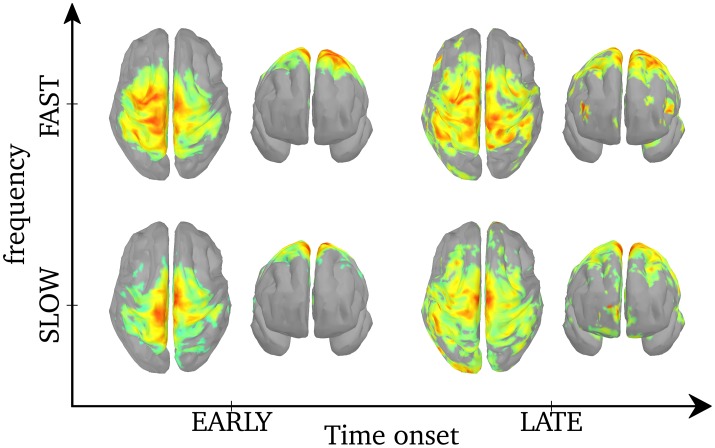
Activation maps associated with each of the 4 categories of SEs. The maps are normalized to a common scale (maximum power in red) and displayed using Otsu's threshold (Otsu, 1979). Based on the histogram of an object (vector or image), Otsu's threshold consists in classifying the object in two classes with minimal intra-class variances, then binarizing the object by setting the intensities of the lower class to 0 and that of the higher class to 1. Unthresholded activation maps are presented in Supplementary Figure 4.